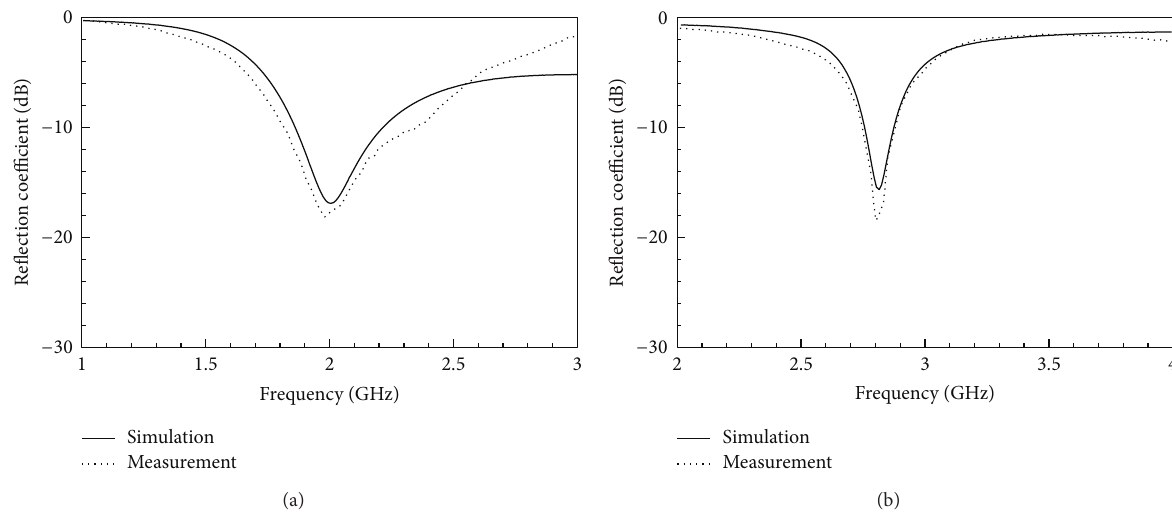
Figure 3: Simulated and measured reflection coefficients of the reference antennas; (a) the monopole antenna and (b) the slot antenna.